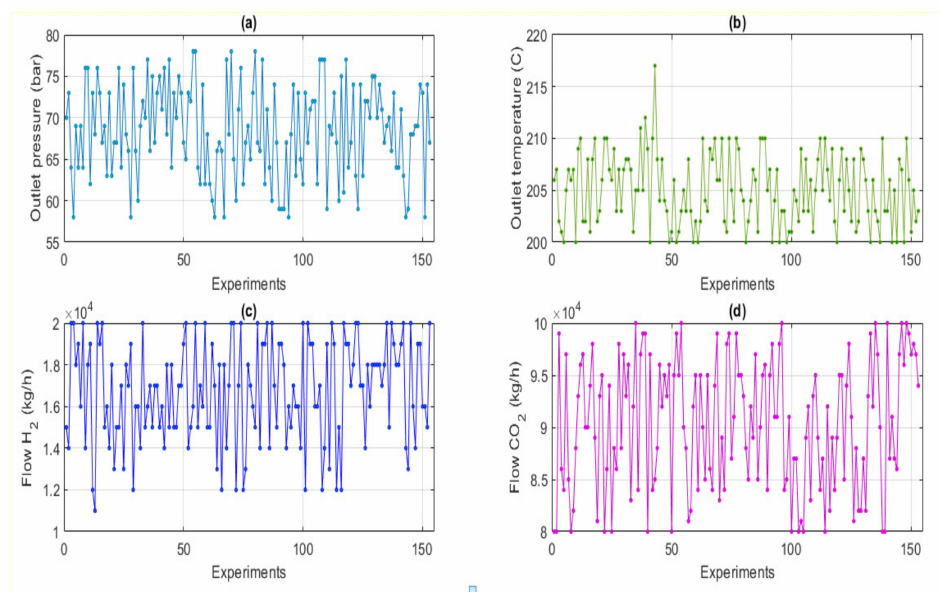
Figure 4. Input values employed to training, validation and testing the ANN. ( a ) Outlet pressure